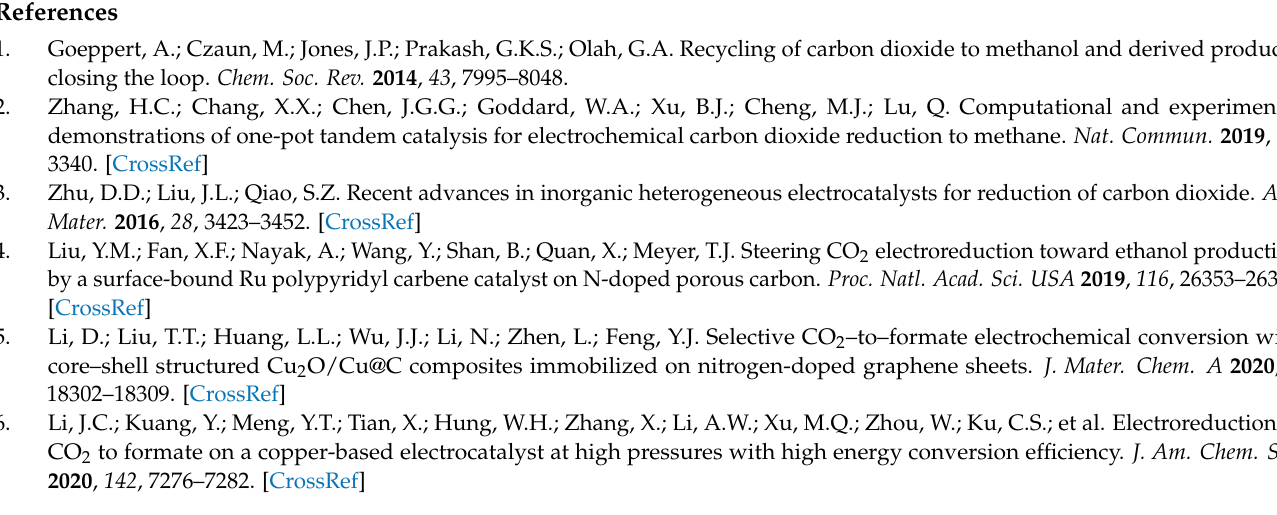
line EDX analysis along the arrow (c) 4ZnO@Cu 2 O and (d) ZnO@20Cu 2 O. Figure S2: XRD pattern of Cu 2 O and its PDF card. Figure S3: Cu LMM Auger spectra of xZnO@yCu 2 O catalysts with different shell thickness. Figure S4: The ratio of Cu 1+ / Cu total with different shell thickness cata- lysts. Figure S5: The current density of C 2 products on xZnO@Cu 2 O catalysts with different shell thickness. Figure S6: Cyclic voltammograms of different catalysts in 0.1 M KHCO 3 (CO 2 -saturated) at scan sates of 50 mV s − 1 , 100 mV s − 1 , 150 mV s − 1 , 200 mV s − 1 , 250 mV s − 1 , and 300 mV s − 1 . (a) Cu 2 O; (b) ZnO@20Cu 2 O; (c) ZnO@4Cu 2 O; (d) 4ZnO@Cu 2 O; (e) ZnO; and (f) double-layer capac- itance measured by cyclic voltammetry in 0.1 M KHCO 3 saturated by CO 2 on the catalysts with different shell thickness. Figure S7: The particle size distribution of (a) ZnO-400, (b) ZnO-600, and (c) ZnO-800. Figure S8: The particle size distribution of (a) Cu 2 O, (b) 4ZnO@Cu 2 O, (c) ZnO@4Cu 2 O, and (d) ZnO@20Cu 2 O. Figure S9: The flow cell used for electrochemical reduction of CO 2 . Table S1: Proportion of elements in the sample measured by ICP-OES. Table S2: The intensity and proportion of different facets of ZnO in the xZnO@yCu 2 O catalyst. Table S3: The intensity and proportion of formation from various Cu-based catalysts. Table S5: The distribution of products at different applied potentials on ZnO@4Cu 2 O catalyst. Table S6: The distribution of products at different